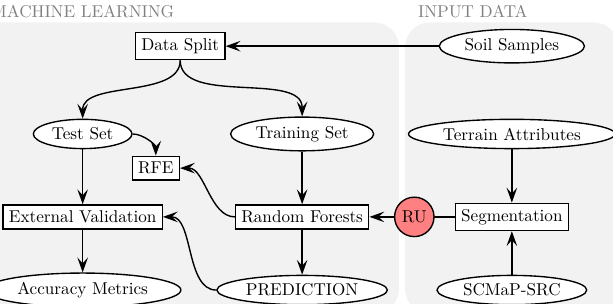
Figure 1. Workflow for the scale-specific SOC content prediction based on SCMaP Soil Re- flectance Composites (SCMaP-SRC) and terrain attributes (RU: reference units; RFE: recursive feature elimination).